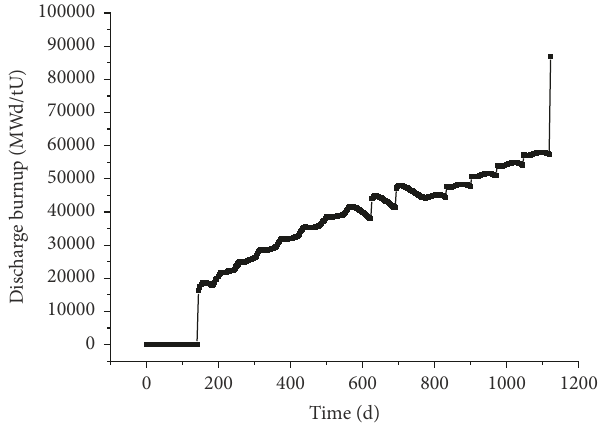
Figure 5: Discharge burnup changing with